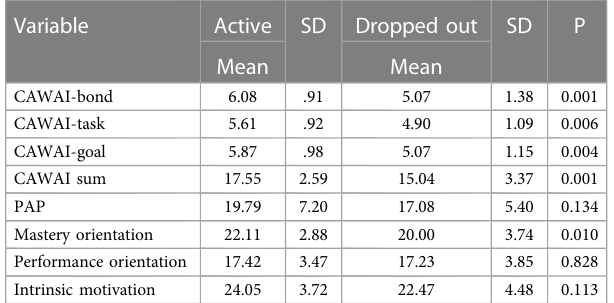
TABLE 3 Hierarchical binary logistic regression analyses based on cross-sectional data collected from the 116 participants where drop-out is the dependent